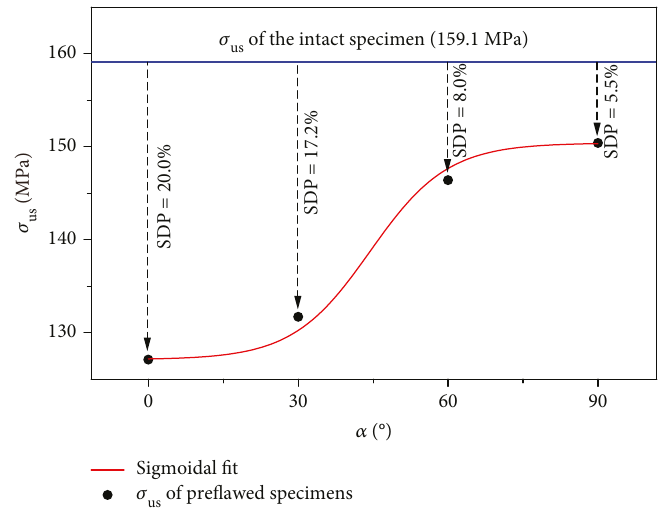
Figure 9: Unloading failure strength σ